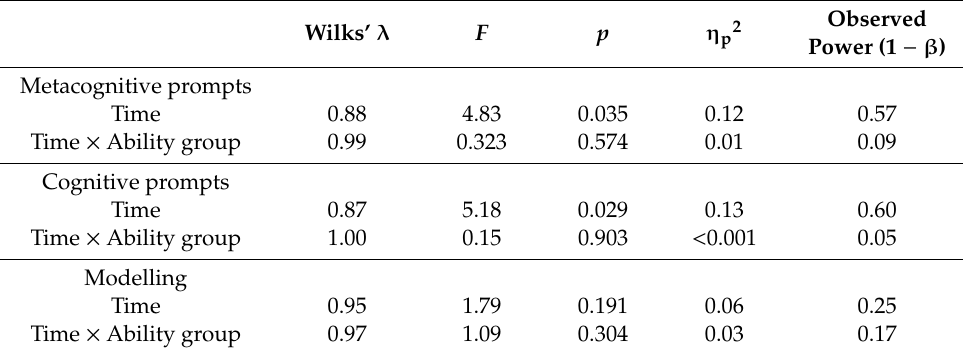
Table 2. Results of the repeated measures ANOVA for changes in children’s instructional needs from the first to the second training session.